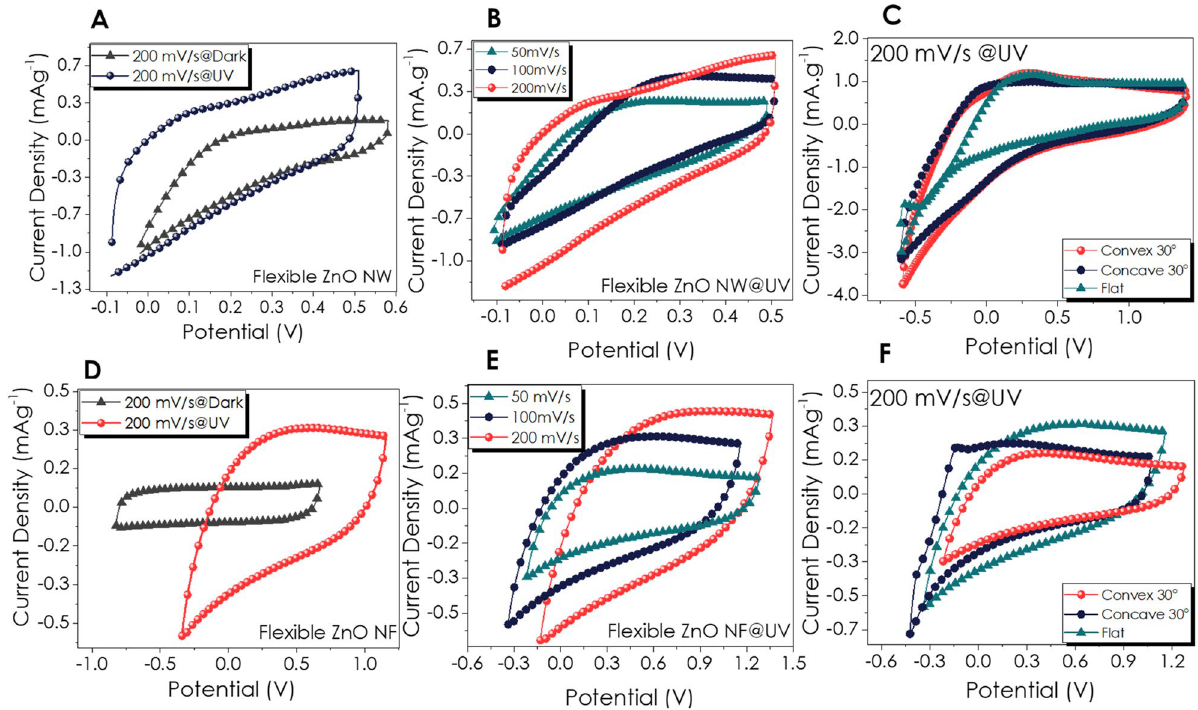
Figure 6. CV curves of flexible ZnO NW based P-SC; ( A ) with 200 mV s −1 scan rate under UV and dark conditions, ( B ) under UV light with different scan rates, ( C ) bent and flat P-SC with 200 mV s −1 scan rate; and flexible ZnO NF based P-SC; ( D ) with 200 mV s −1 scan rate under UV and dark conditions, ( E ) under UV light with different scan rates, ( F ) bent and flat P-SC with 200 mV s −1 scan time under UV. The GCD curves with varying current density at dark conditions have been given in Supporting Information (Figure S5, Supporting Information). On the other hand, the GCD curves of the ZnO NF-based photo-supercapacitor device have displayed a shorter charging-discharge time resulting in lower overall CE% for both dark and illuminated compared to the ZnO NW (Fig. 5D–E). In Fig. 5F, the CE% and specific capacitance values have been much less than that of ZnO NW due to the shortening discharge time. The capacitance data at low current density (1.1 mA g −1 ) have been used to determine the energy density as 78.1 and 11.4 mWh kg −1 for NW ad NF, respectively. Furthermore, the